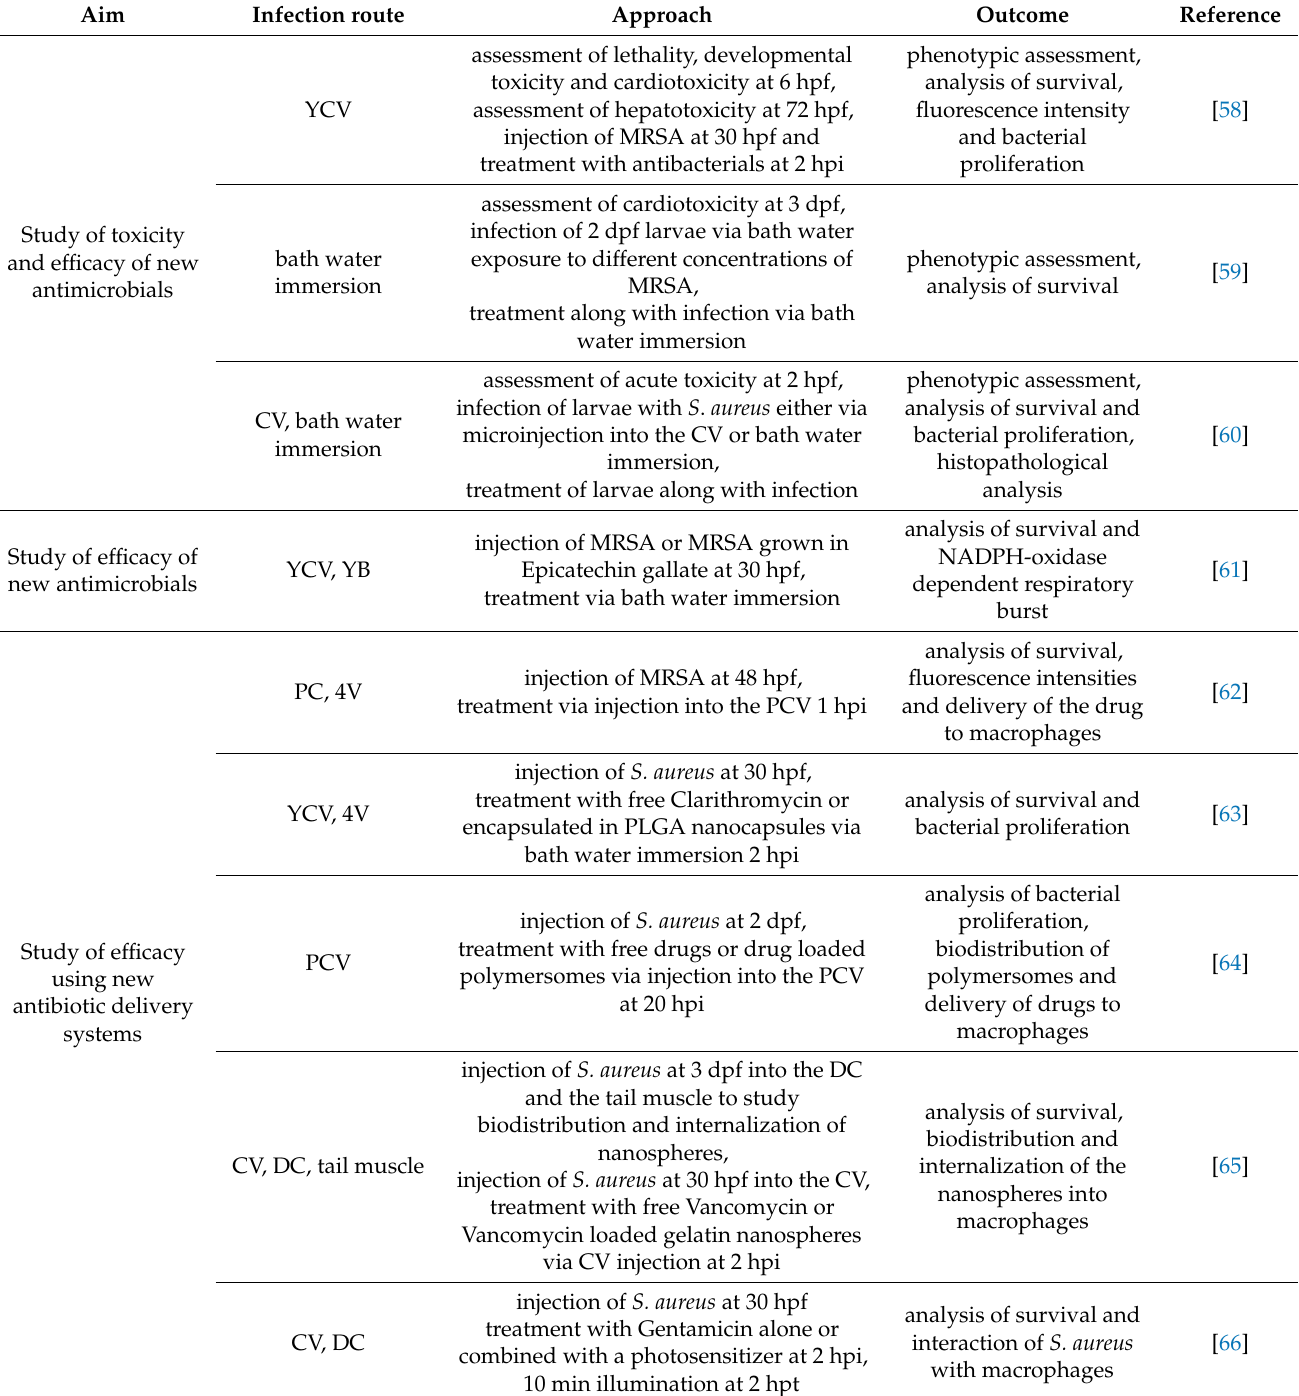
Table 2. Reported studies of zebrafish larvae models in Staphylococcus aureus drug discovery. YCV: yolk circulation valley; CV: caudal vein; YB: yolk body; PC: pericardial cavity; 4V: fourth hindbrain ventricle; DC: Duct of Cuvier; PCV: